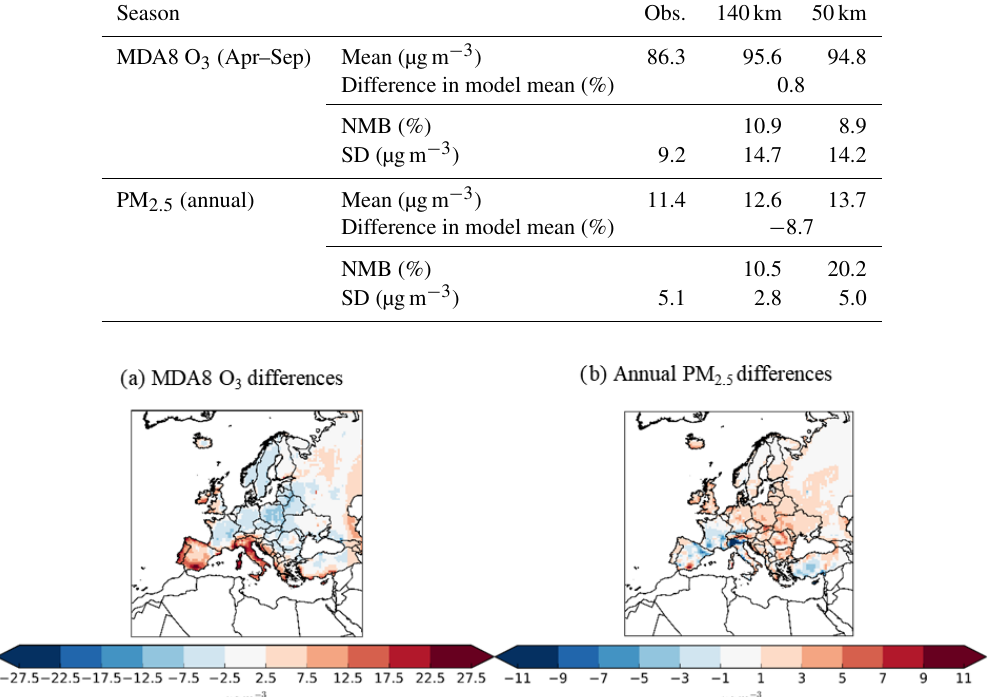
Table 3. Warm season (April–September) mean of daily maximum 8h running mean O 3 concentrations (MDA8 O 3 ) and annual mean PM 2 . 5 concentrations at the coarse and finer resolutions compared to observations from 52 and 25 stations within the EMEP network, respectively.